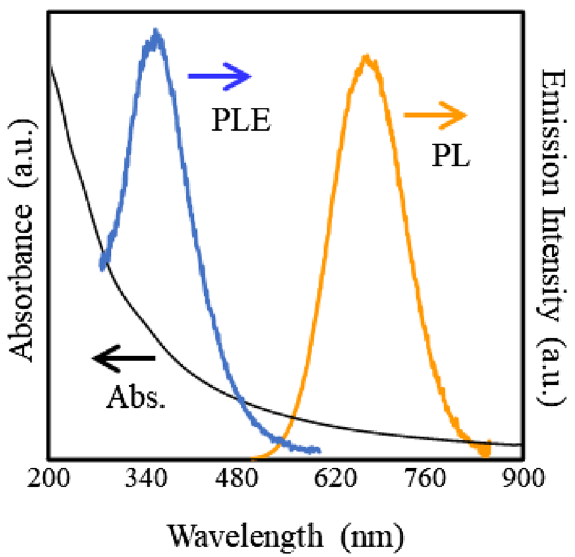
Figure 2. A typical optical absorption, excitation and emission spectra of the Product